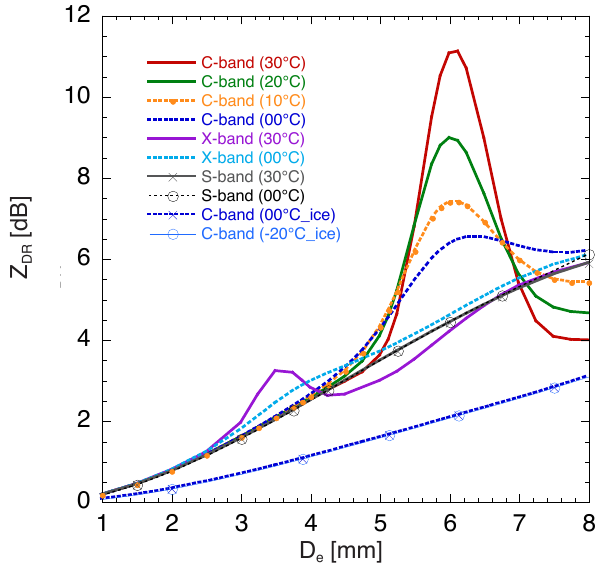
Fig. 2. Differential reflectivity ( Z DR ) as a function of equivol- Figure 2. Differential reflectivity ( Z ) as a function of equivolumetric sphere diameter ( D DR umetric sphere diameter ( D e ) at raindrop temperatures of 0 and raindrop temperatures of 0°C and 30°C at the S-band (2.725 GHz), C-band (5.370 GHz), and 30 ◦ C at the S-band (2.725GHz), C-band (5.370GHz), and X-band X-band (9.375 GHz). Results for temperatures of 10°C and 20°C, and iced raindrops at 0°C and (9.375GHz). Results for temperatures of 10 and 20 ◦ C, and iced raindrops at 0 and − 20 ◦ C are also plotted for the -20°C are also plotted for the C-band.